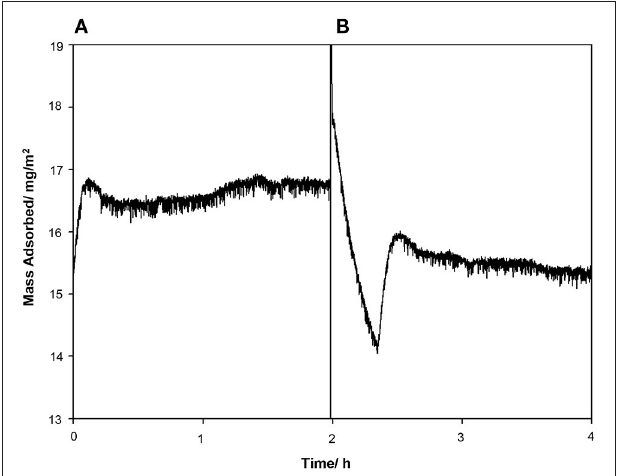
FIGURE 1 | QCM data showing the (A) protein injection and (B) washing cycles. After the washing cycle the final measured mass adsorbed to the surface was 15.2 mg/m 2 .